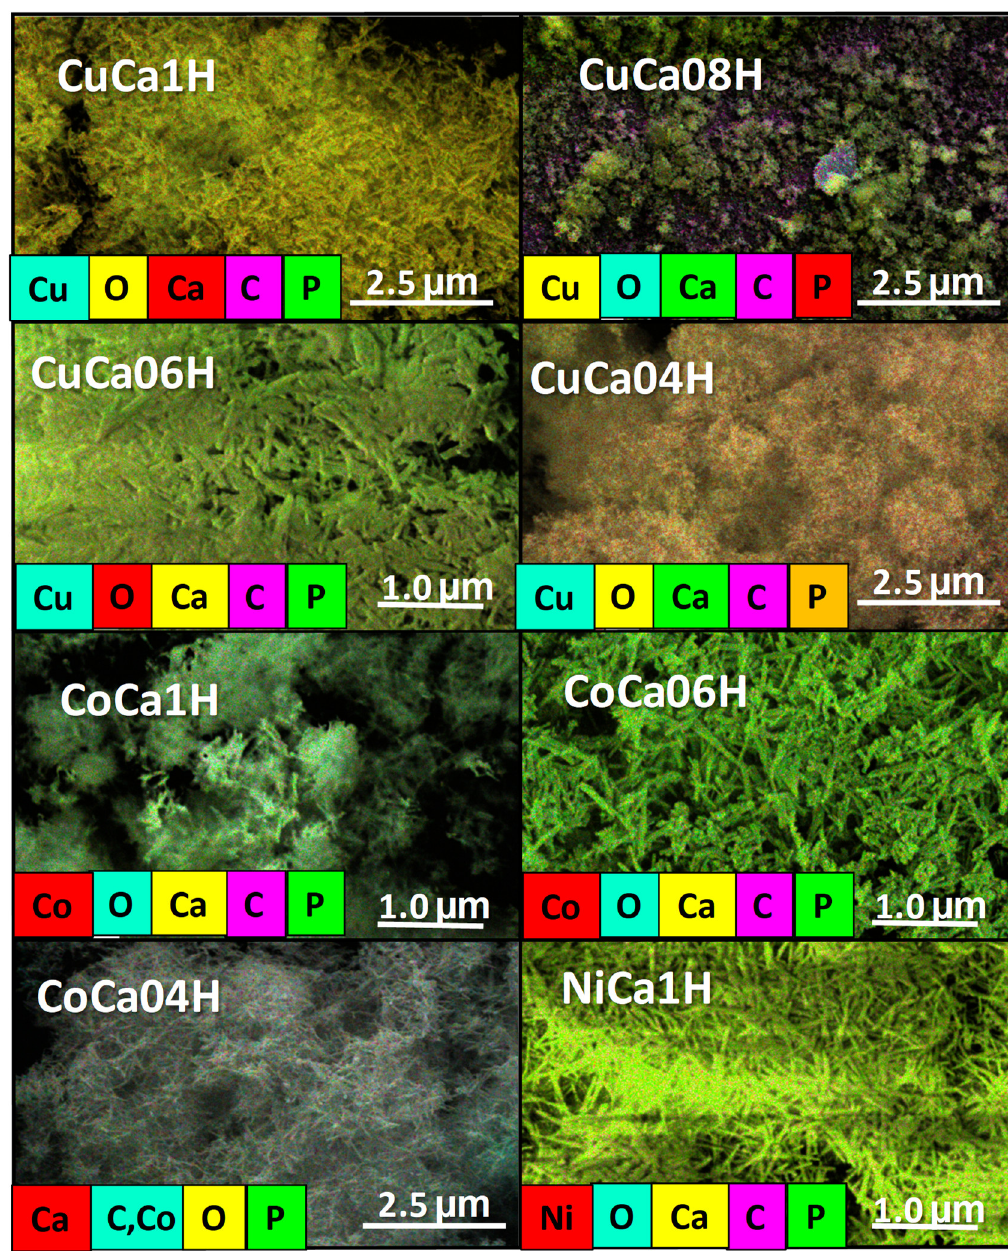
Figure 9. EDS mapping of the corresponding SEM micrographs for spent solids. The solids are evaluated in the EG reaction at 80 °C and glycerol to acetic acid molar ratio of 0.25.